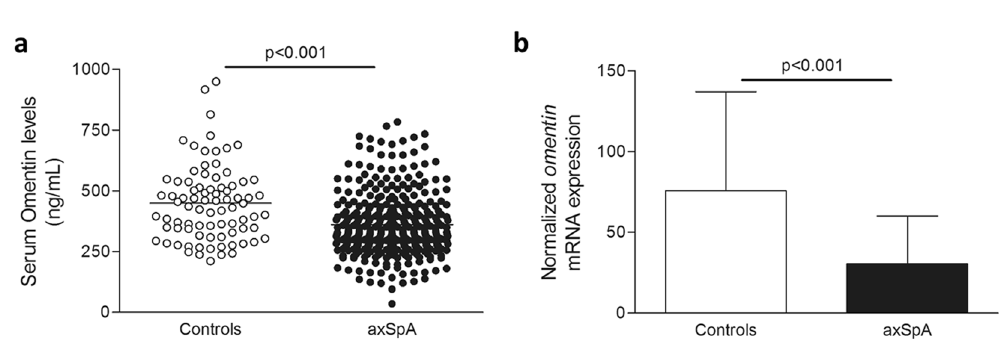
Figure 1. Omentin levels in axSpA and controls. Reduced serum ( a ) and mRNA expression ( b ) levels of omentin in axSpA patients when compared to healthy controls, after adjustment for potential confounding factors. Horizontal bars in Fig. 1a indicate the mean value of each